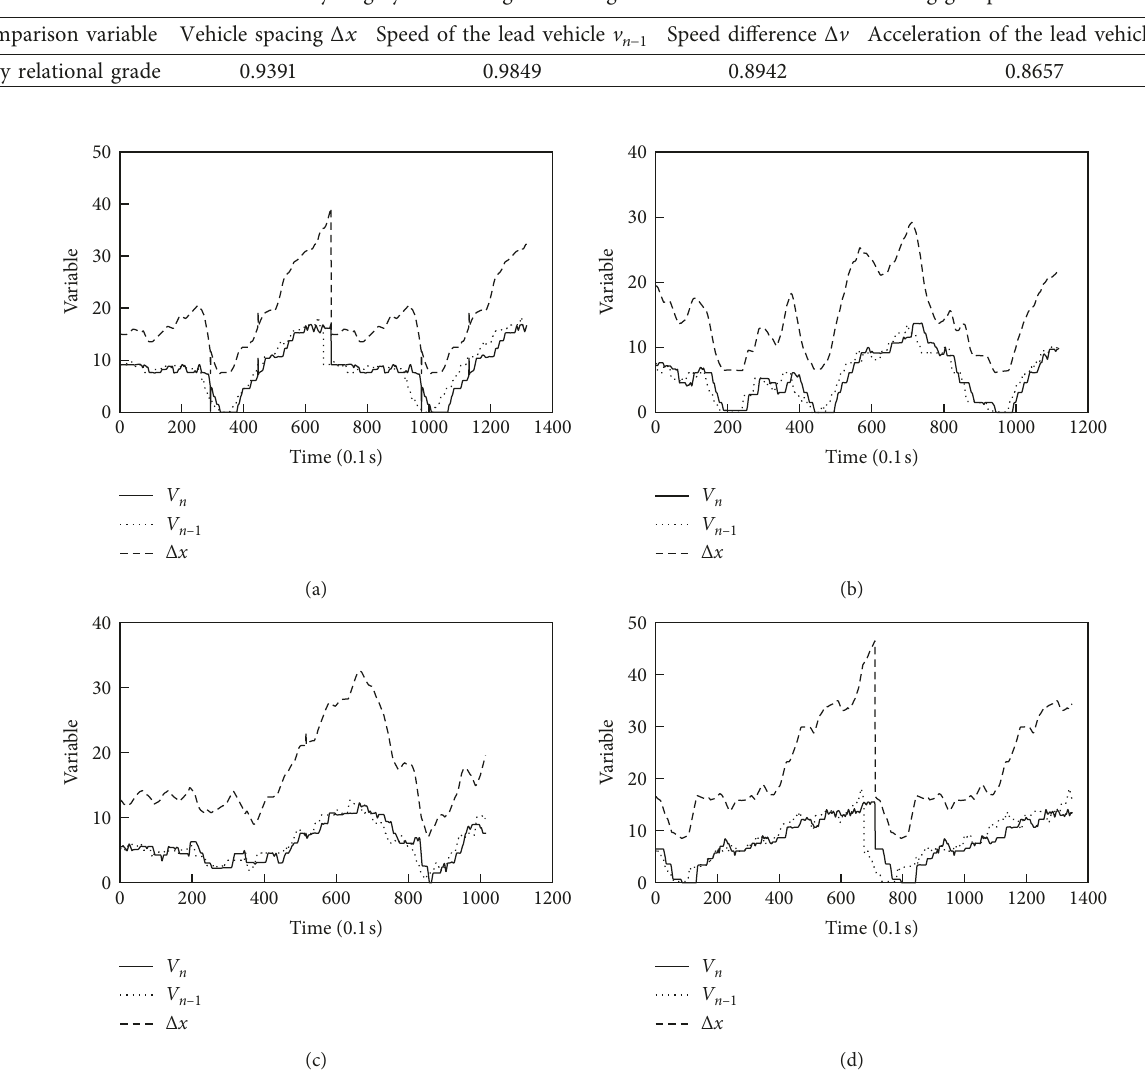
Table 3: Summary of grey relational grades using data associated with car-following groups.